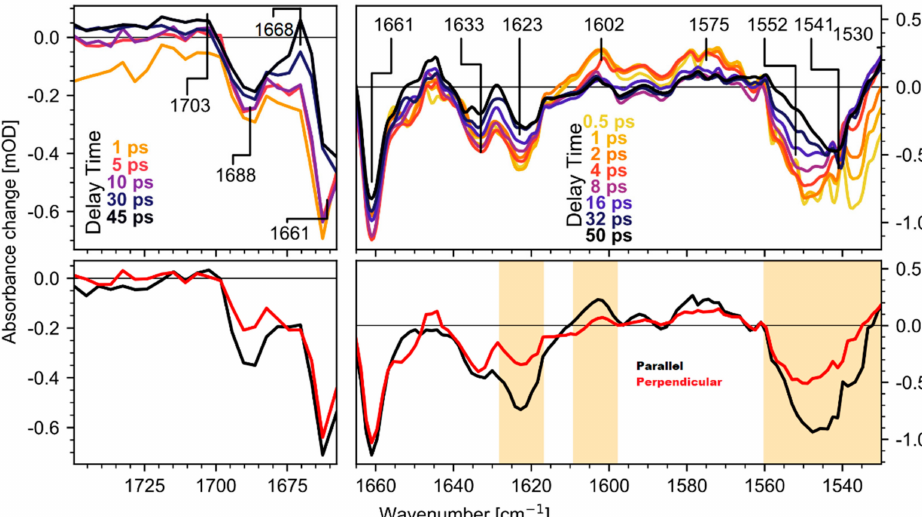
Figure 2. Transient absorption spectra of Ca CR1 after excitation at 530 nm in the range of 1730 cm − 1 to 1656 cm − 1 (left panels) with a spectral resolution of 4 cm − 1 , and 1665 cm − 1 to 1530 cm − 1 (right panels) with a spectral resolution of 2 cm − 1 . Top row: Isotropic absorption changes for selected delay times for both spectral regions. Bottom row: From 3 ps to 8 ps averaged absorption changes for parallel (black lines) and perpendicular (red lines) polarizations of pump and probe. Orange shaded regions indicate spectral regions with dominating retinal